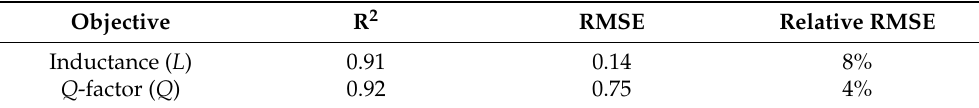
Table 2. Accuracy metrics for meta-models of L and Q